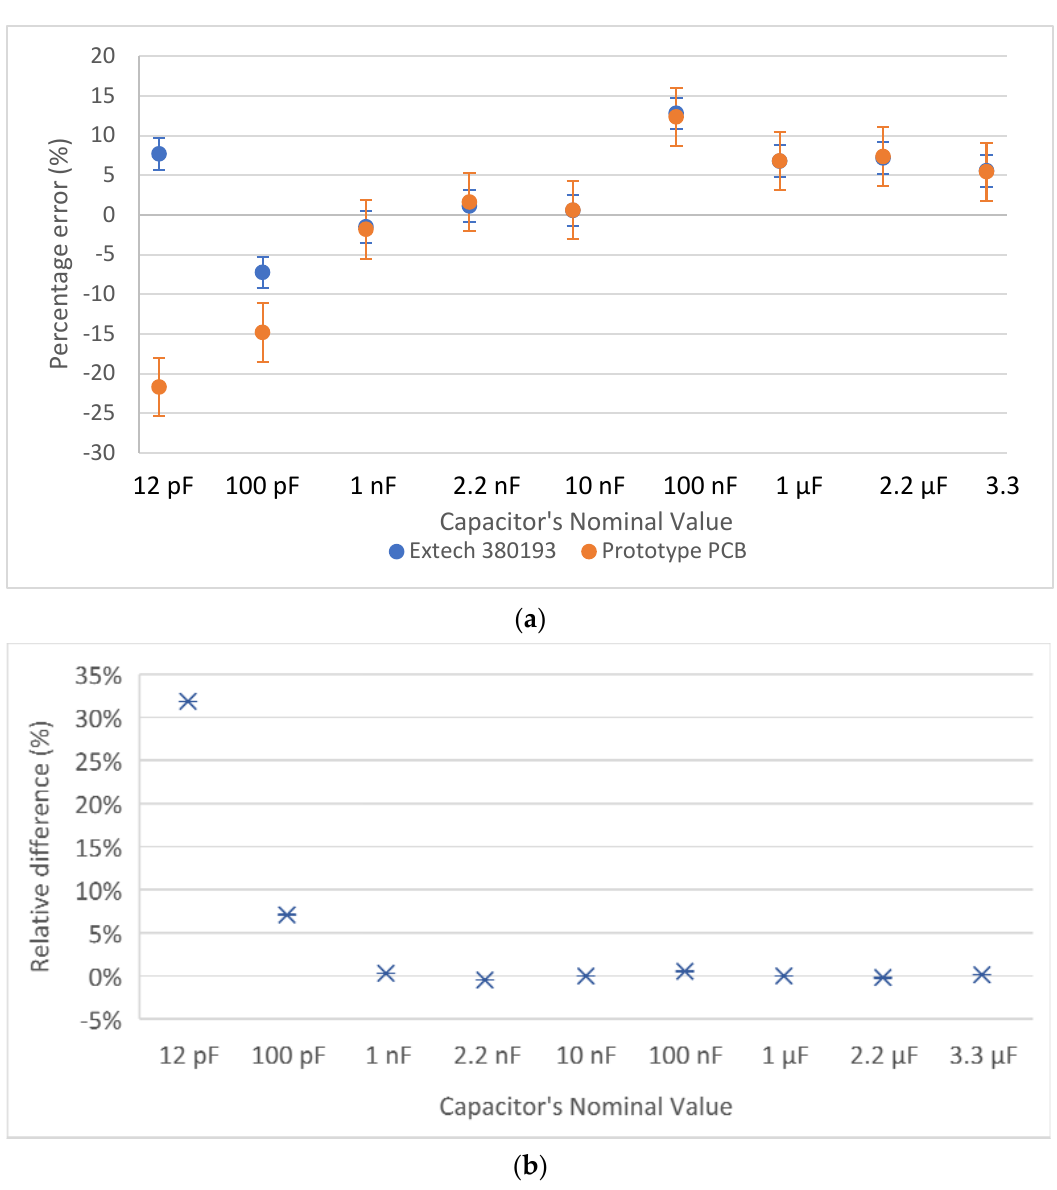
Figure 4. Capacitance measurements of 9 capacitors; ( a ) the absolute percentage difference between the nominal capacitance value, an LCR meter, and the developed circuit; ( b ) the relative difference between the developed circuit and the reference LCR meter.